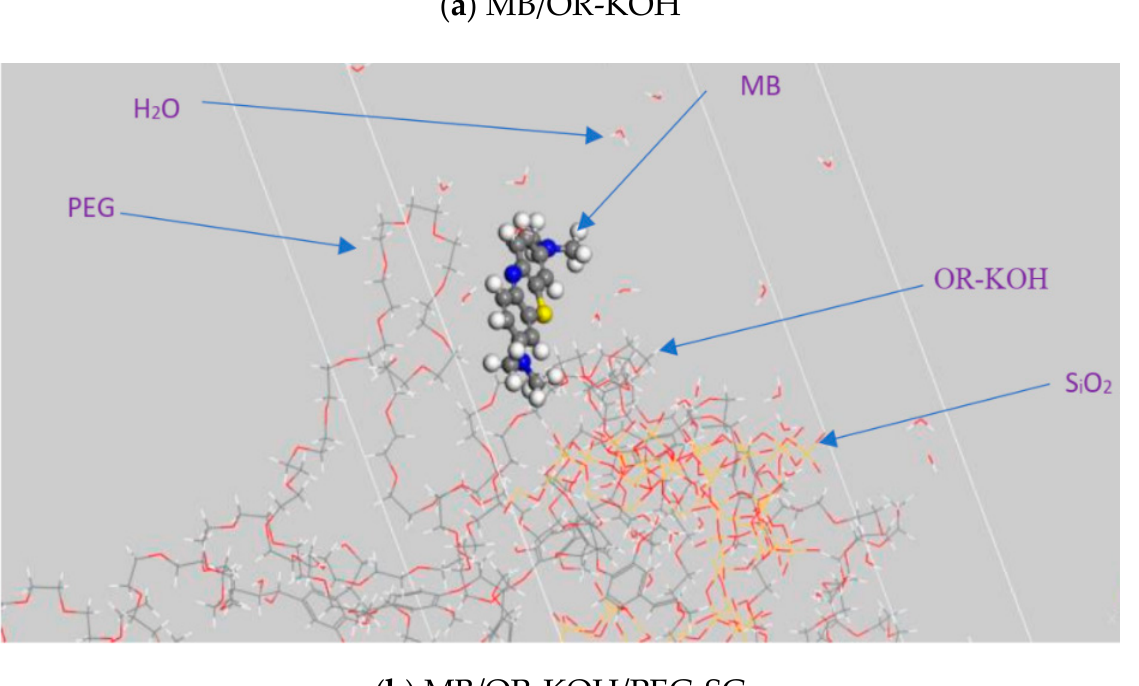
Figure 6. Adsorption of MB in aqueous solution on different adsorbents: ( a ) OR ‐ KOH and ( b ) OR ‐ KOH/PEG ‐ SG.